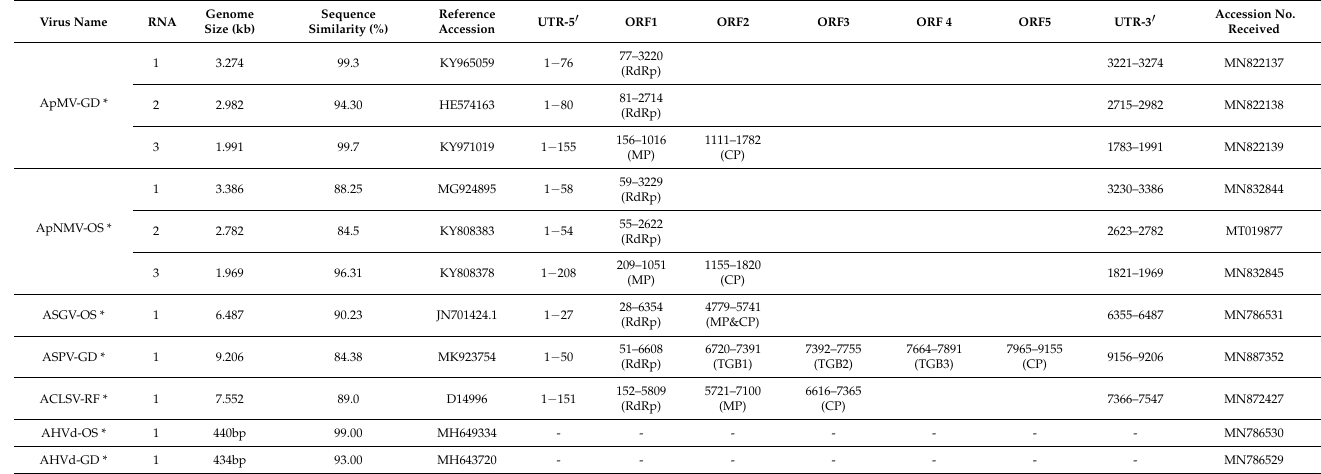
Table 3. The genome size, organization, sequence similarity and accession numbers of viruses identified from apple leaf samples from next-generation